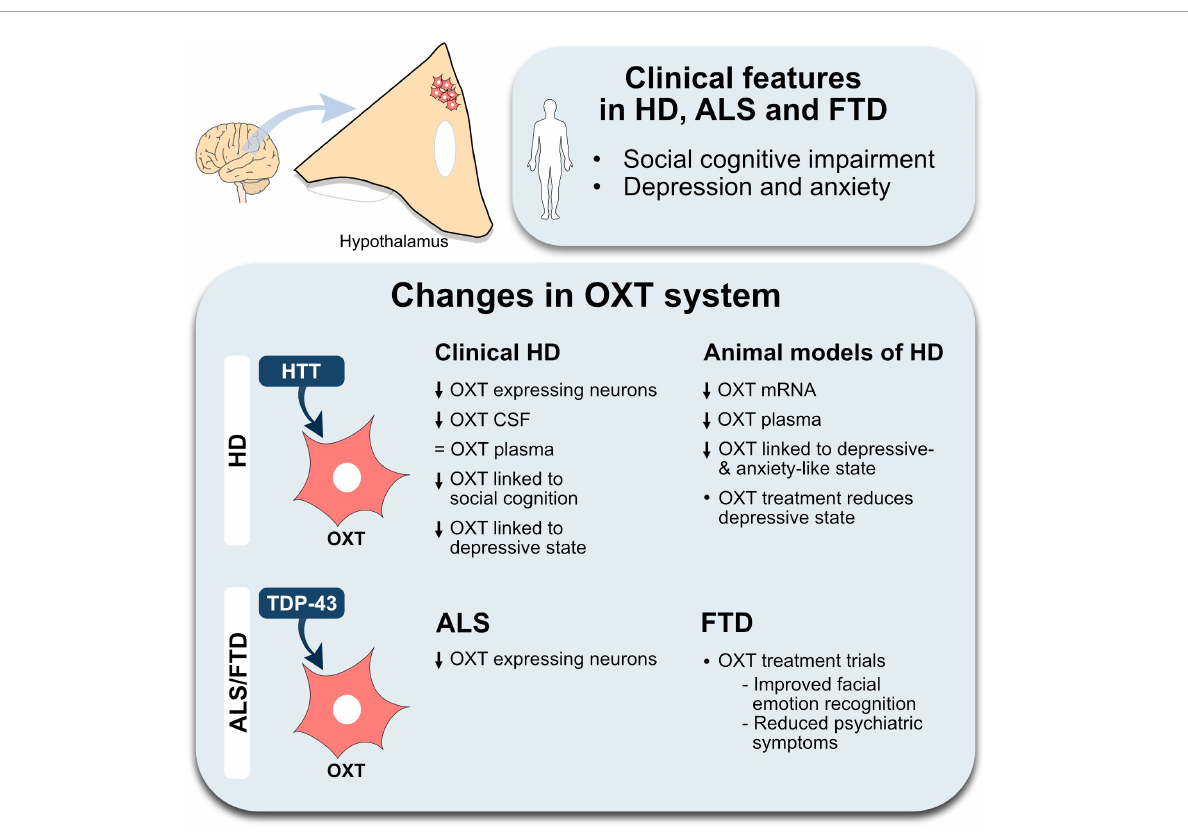
FIGURE1 An overview of changes in the oxytocin system in Huntington’s disease and amyotrophic lateral sclerosis-frontotemporal dementia. The illustration summarizes the main positive results from studies investigating the oxytocin (OXT) system in Huntington’s disease (HD), amyotrophic lateral sclerosis (ALS) and frontotemporal dementia (FTD). A decrease is indicated by the downward arrows, lack of change is indicated by an equal sign. Abbreviations, CSF, cerebrospinal fluid; HTT, huntingtin; TDP-43, transactive response DNA-binding protein 43